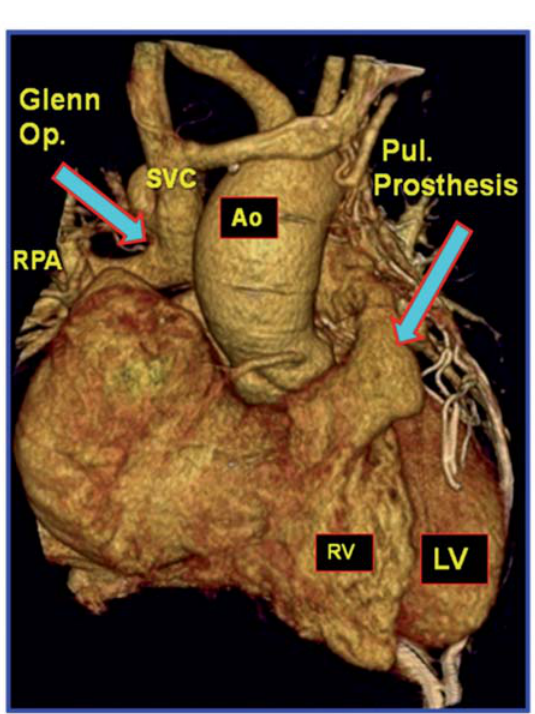
defectFig. 5 - Postoperative CT angiography 3D reconstruction showing: Glenn operation and pulmonary prosthesis implanted. Ao = aorta; RPA = right pulmonary artery; RV = right ventricle; LV =